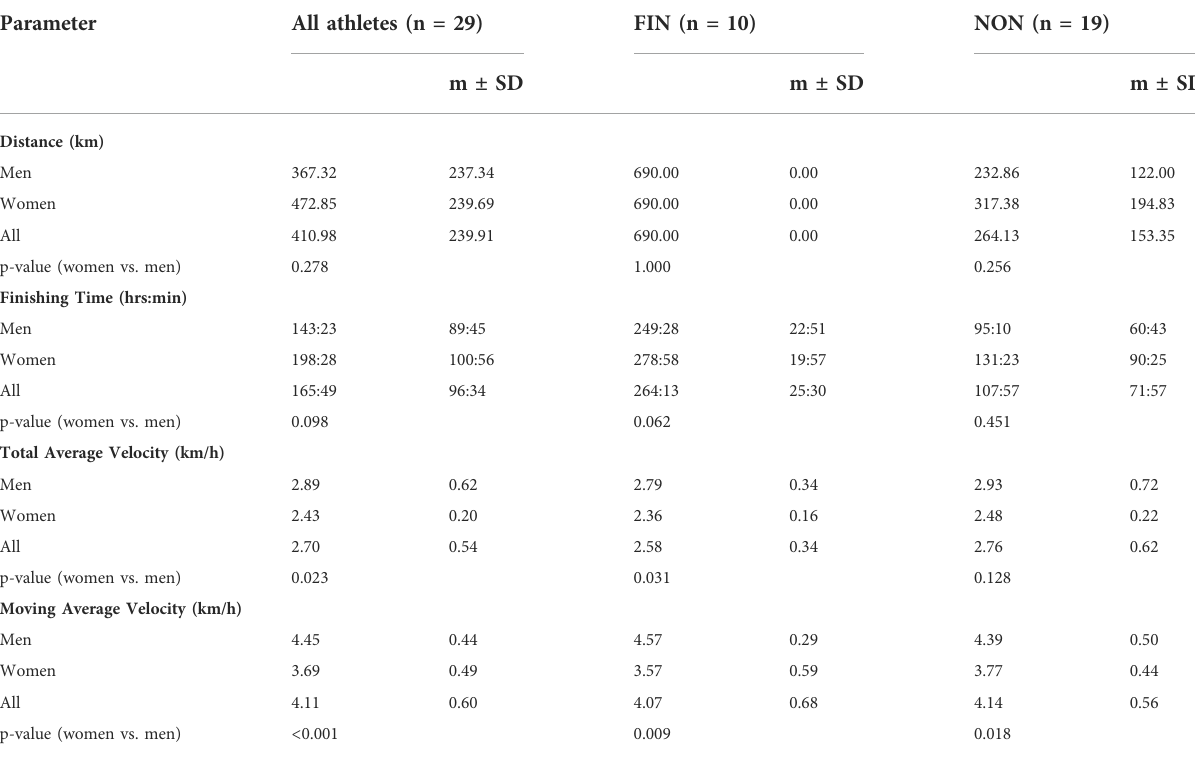
TABLE2Women vs.men ’ sperformancedatafor fi nishersandnon- fi nishers.Theoverallcompleteddistance, fi nishingtime,andthetotalandmoving average velocity. FIN = Finisher, NON = Non- fi nisher, m = mean, SD = Standard Deviation.